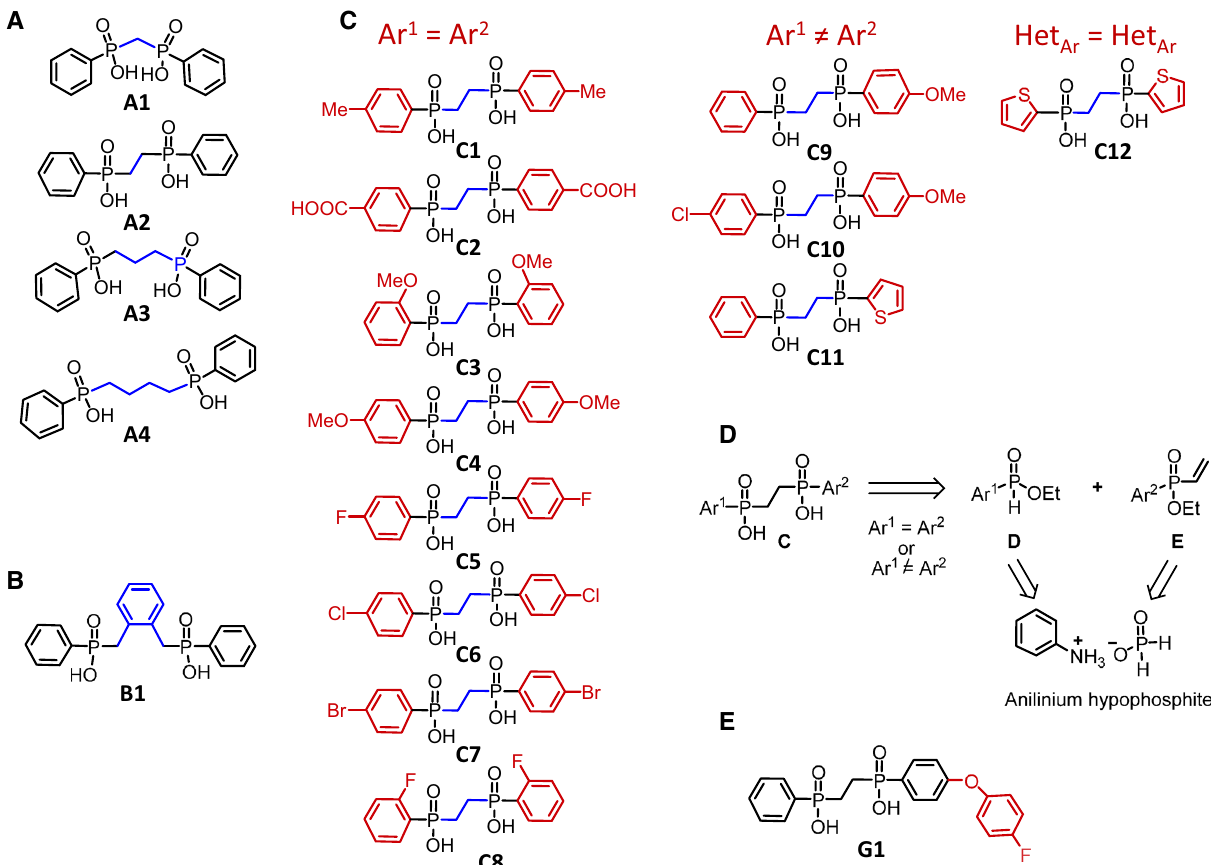
Figure 4. Structure of the synthesized c407 analogs. ( A ) c407 analogs with various chain length. ( B ) c407 analogs with modification of the chain rigidity. ( C ) Symmetrical or asymmetrical c407 analogs with different aromatic or heteroaromatic rings. ( D ) Retrosynthetic strategy towards compounds C1–C4, C6–C12 and G1. ( E ) Structure of the extended c407 analog,